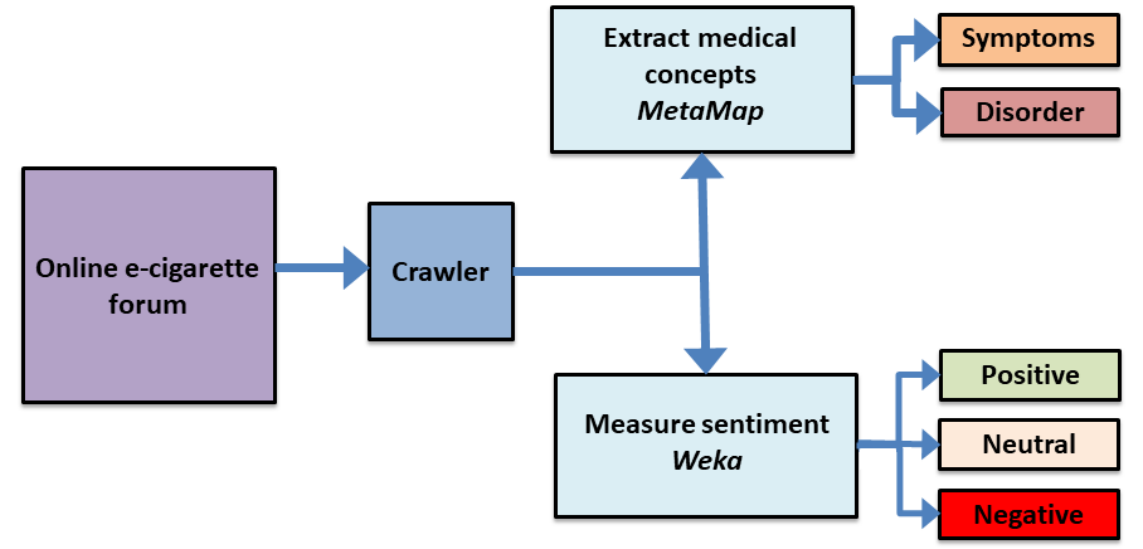
Figure 1. Online forum data pipeline showing processing, post sorting, and classification workflow.